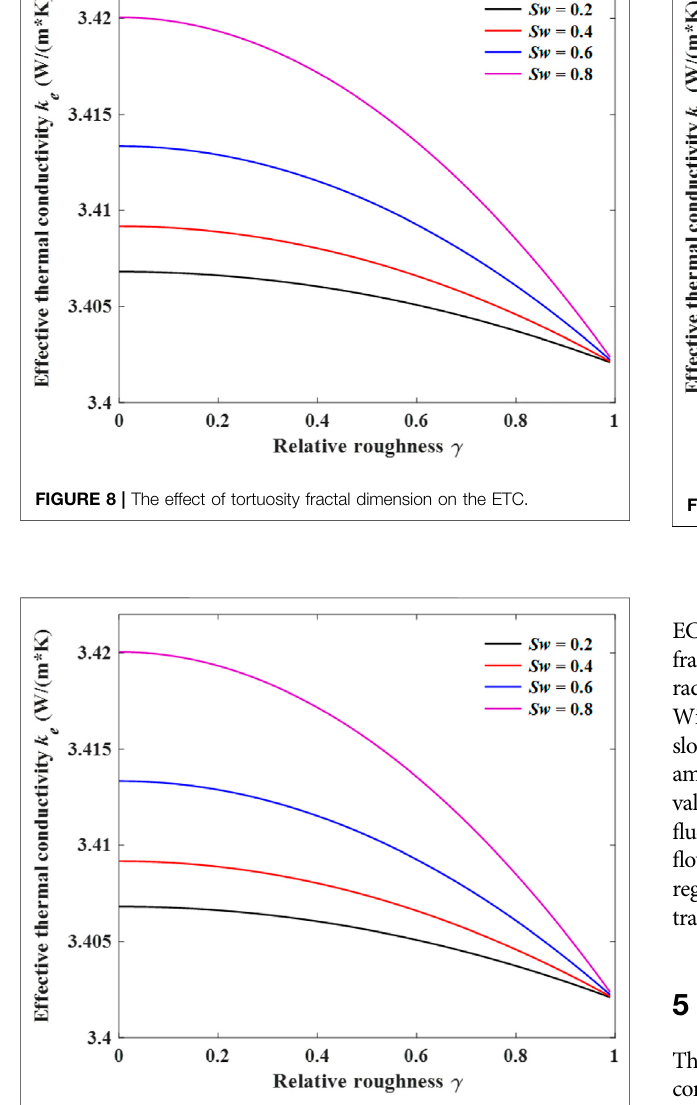
FIGURE 9 | The effect of relative roughness on the ETC.